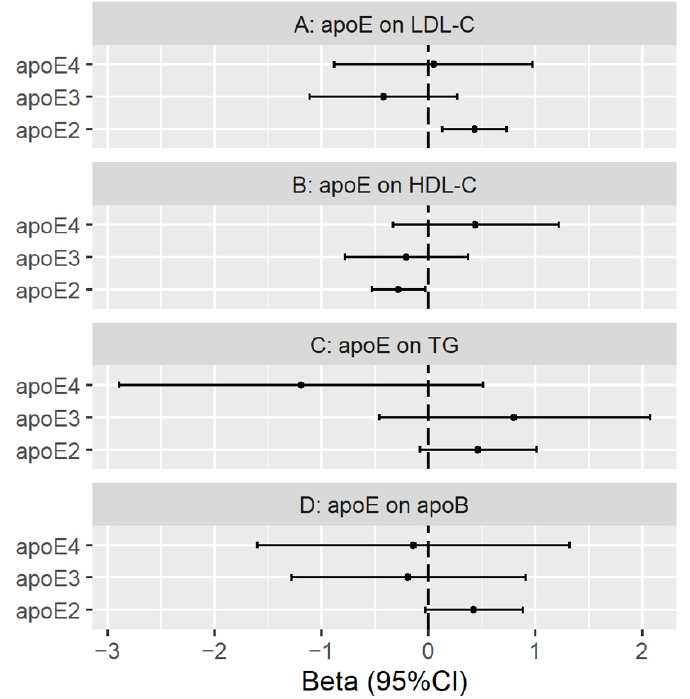
Figure 4. Multivariable MR estimates for plasma apolipoprotein E2 (apoE2), apolipoprotein E3 (apoE3) and apolipoprotein E4 (apoE4) on low-density lipoprotein cholesterol (LDL-C), high-density lipoprotein cholesterol (HDL-C), triglycerides (TG) and apolipoprotein B (apoB) using inverse variance weighting with genetic predictors from the KORA study.